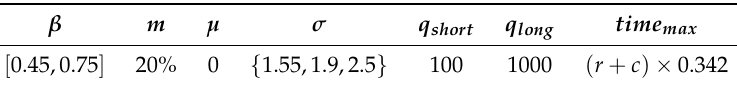
Table 2. Parameter